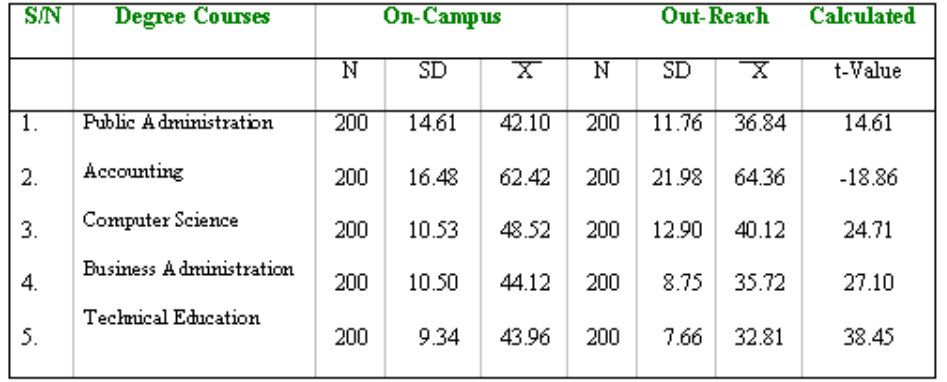
Table 3. Summary of t -Test Analysis of the Students Academic Achievement between On- campus and Outreach Part-time Degree